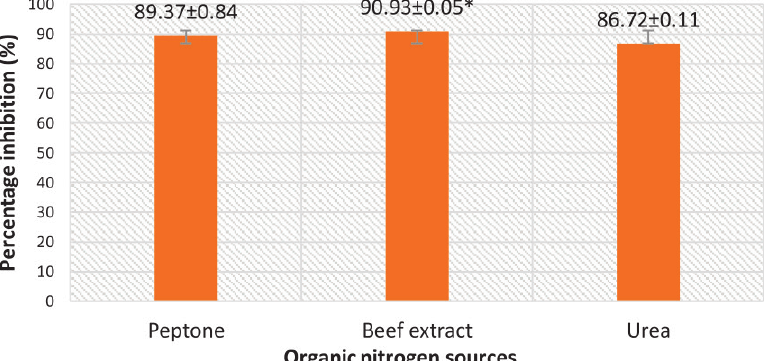
Fig 5. Percentage inhibition of A. flavus growth in different organic nitrogen sources with maximum inhibition obtained for Beef extract. Inhibition percentage = (Control- Test/ Control) x100. Values are represented as Mean ± SD (n=3). *Value is statistically significant at P ≤ 0.05 in t-